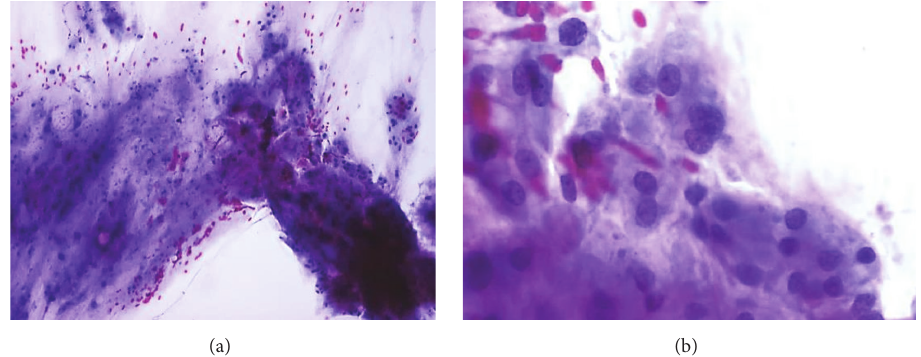
Figure 4: FNA Diff-Quik smears, low and higher power images show metastatic chordoma (fragments of fibrillary matrix material intimately admixed with epithelioid cells in a background of red blood